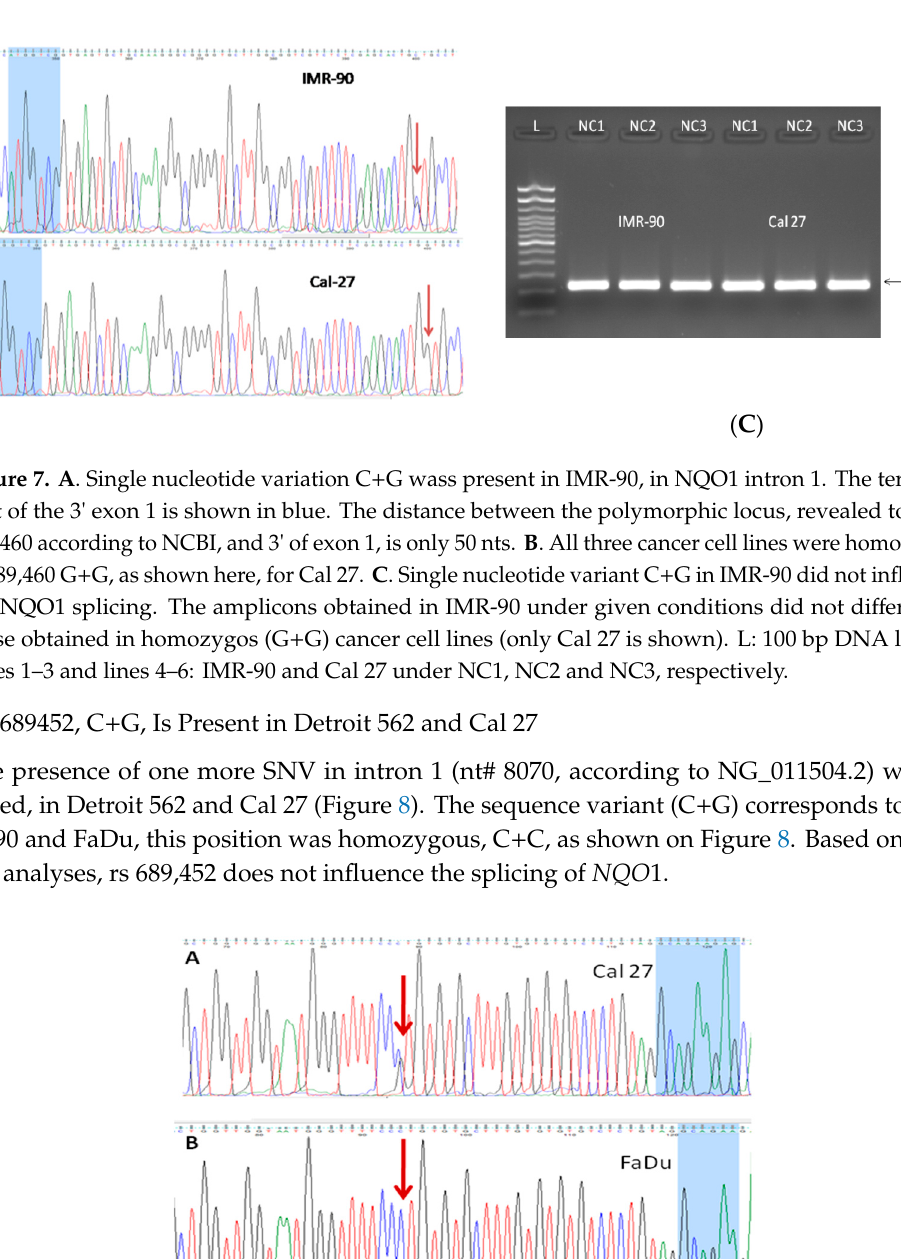
13 of 28 Figure 6. The dependence of the TV1/TV3 ratio on NCs applied. One-way ANOVA with Tukey post- hoc test. The ascending trends were recorded in Cal 27 as contrasted with the other three cell lines. The values are shown as the mean ± SD. n = 3. * p < 0.05; ** p < 0.01; *** p < 0.001; **** p < 0.0001. The signal obtained from TV4 was permanently low in all cell lines, under all NCs applied, and was excluded from the analyses. The intensity of the densitometric signal originating from TV1 and TV3 was expressed as their ratio (TV1/TV3) obtained after 28 PCR cycles (Supplementary Figure 1). The opposite trends in Cal 27 versus three other cell lines were observed. In Cal 27, the TV1/TV3 ratio increased from 4.47 (NC1) to 5.7 (NC2) and 6.36 (NC3) (Figure 6). The differences were statistically significant: NC1 versus NC2: p = 0.0020; NC1 versus NC3: p = 0.0006; NC2 versus NC3: p = 0.0123. In IMR-90, Detroit 562 and FaDu, the TV1/TV3 ratio was significantly decreased under NC3 (NC1 versus NC3; IMR-90: p = 0.0014; Detroit 562: 0.0213; FaDu: p = 0.0069). There were also significant differences between the ratio of TVs which was observed between NC2 and NC3 (IMR-90: p = 0.0017; Detroit 562: p = 0.0261; FaDu: 0.0031). 3.4. Detection of SNVs in Intron/Exon Boundaries 3.4.1. rs 689460, G+C, Is Present in IMR-90 and Does Not Influence the NQO1 Splicing Based on the one paper showing that the polymorphism present at the very end of NQO 1 exon 4 (rs1131341) favors occurrence of the transcript lacking exon 4 [31], and based on the cDNA end- point PCR and sequencing data, the status of the cells with respect to rs1131341 was determined. All exon/intron boundaries with primers shown in Table 1 were analyzed, using the gDNA as a template. All primers, except primer NQO1 g6R (complementary to nucleotides in the 5' part of the exon 6), were complementary to intronic/non-coding NQO1 DNA sequence. With these sets of analyses, we discovered a polymorphism in intron 1 (nt #248, according to NG_011504.2), present only in IMR-90 genomic DNA (Figure 7A), but not in the cancer cell lines (Figure 7B). To date, there is no data on the